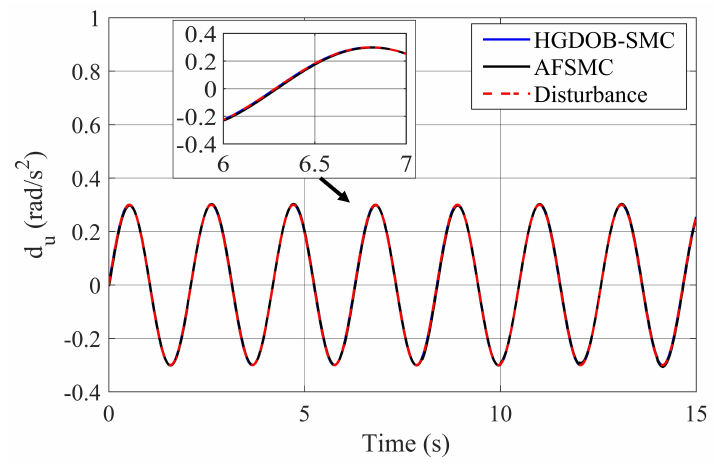
Figure 6. Disturbance d u and estimated